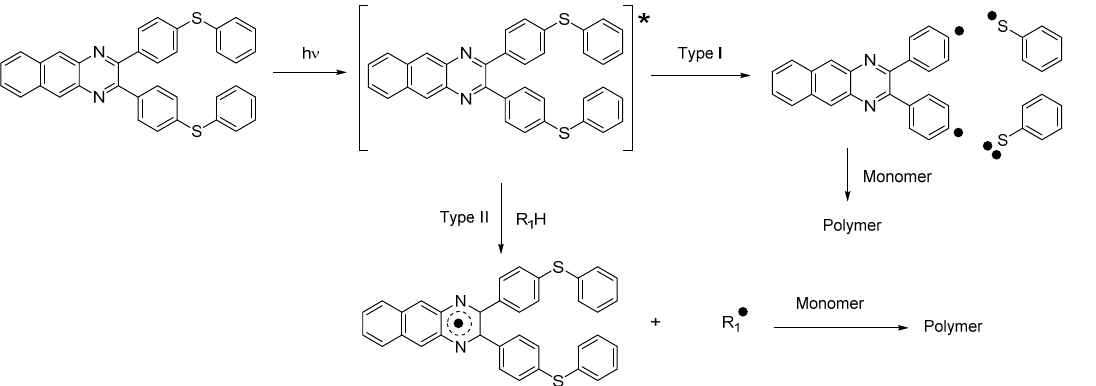
Figure 31. Chemical structures of diphenylquinoxaline derivatives (SQs) with phenyl-thioether units.